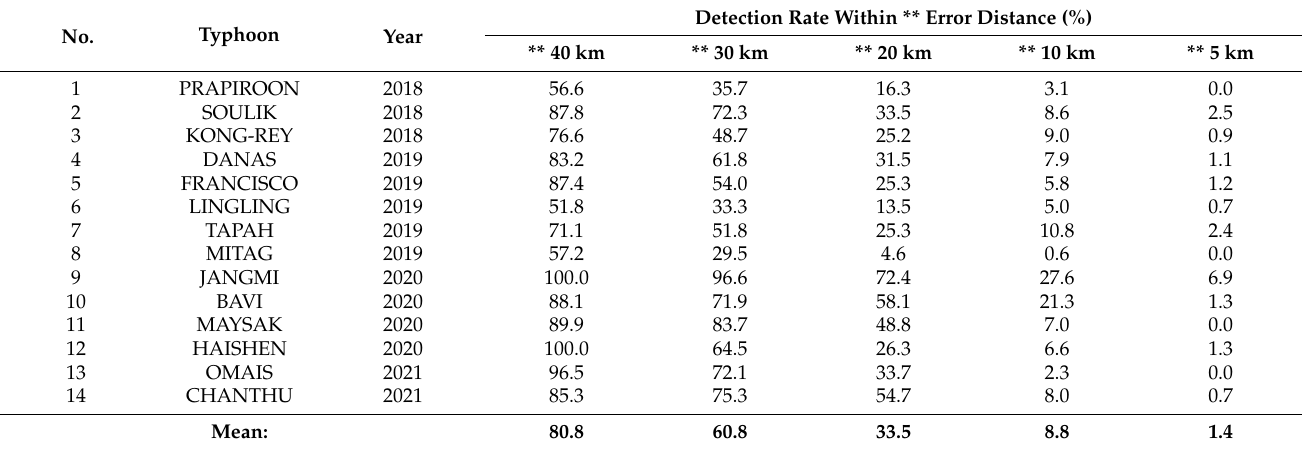
Figure 8. Composite images of radar reflectivity of typhoons that affected the Korean Peninsula between 2020–2021: ( a ) “JANGMI”, ( b ) “BAVI”, ( c ) “MAYSAK”, ( d ) “HAISHEN”, ( e ) “OMAIS”, and ( f ) “CHANTHU”. Table 2. Detection rate by error distance of ACTION results for typhoons that affected the Korean Peninsula between